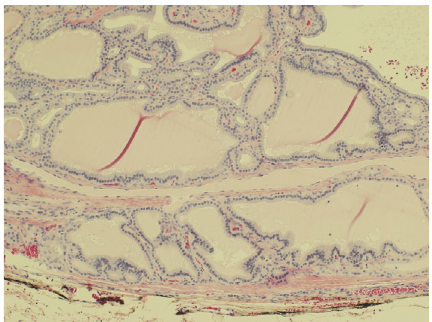
Figure 3: Photomicrograph of the edge of the dominant nodule, showing irregularly dilated follicles with pale colloid and subtle infoldings of the follicular epithelium. The follicular cells are uniform and evenly spaced, without features of papillary thyroid carcinoma (H&E,